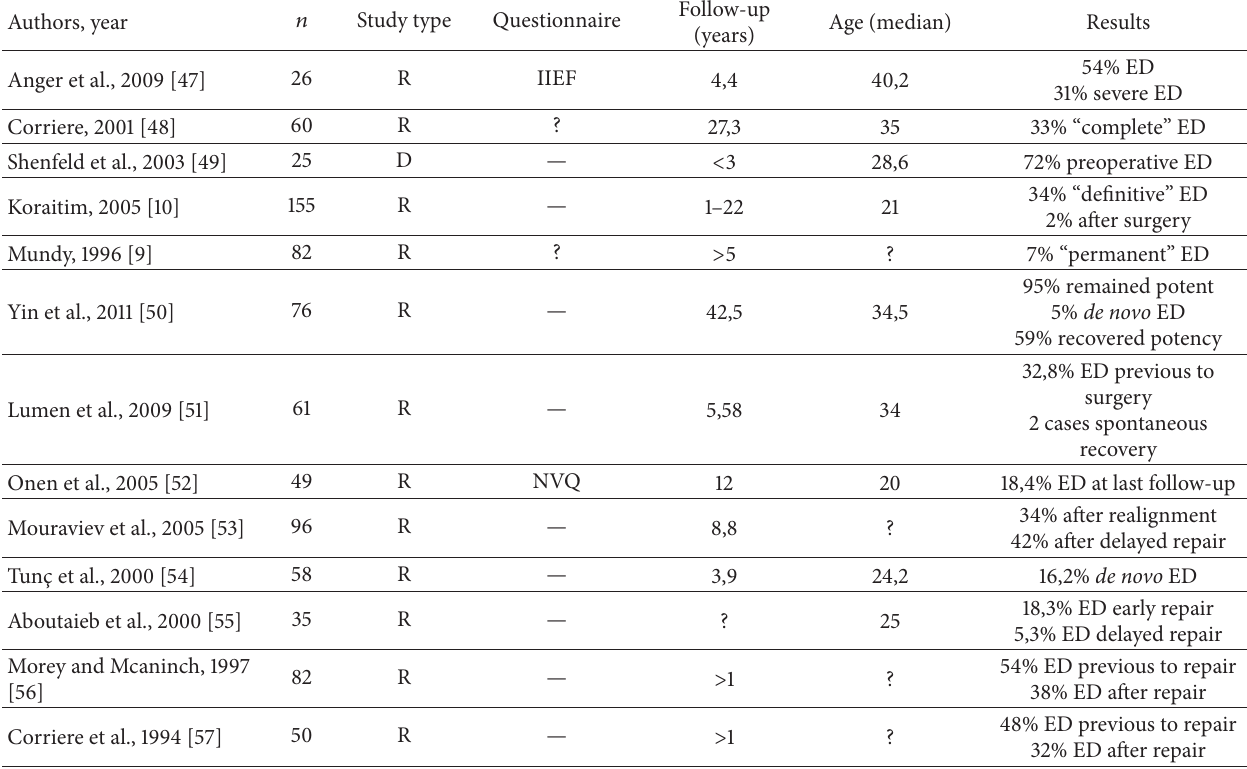
Table 4: Posterior urethra, erectile